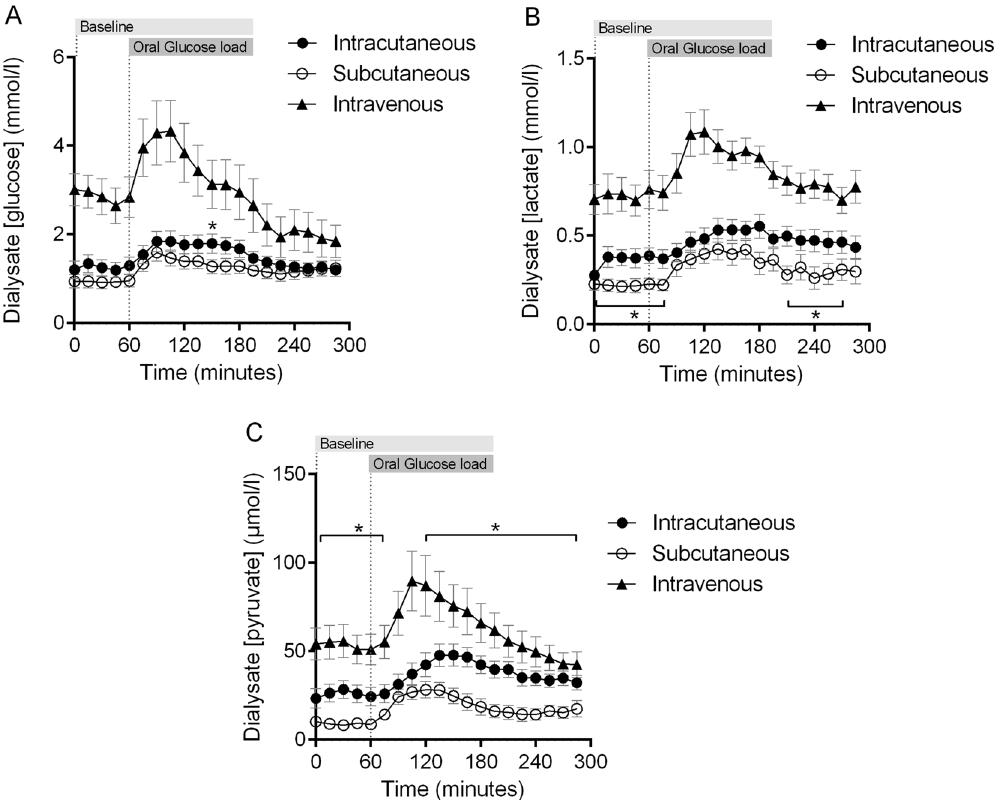
Figure 3. Mean change in dialysate concentration of glucose, lactate and pyruvate in the intracutaneous, subcutaneous and intravenous compartment after oral intake of 75 g glucose load in healthy subjects (N = 11). The concentration of glucose, lactate and pyruvate were all significantly higher in the intravenous catheter than the intra- and subcutaneous catheters during the whole experiment, with one exception for pyruvate 270 min into the experiment. *Indicates a significant difference between the intra- and subcutaneous catheters. Error bars represent standard error of the mean (SEM).